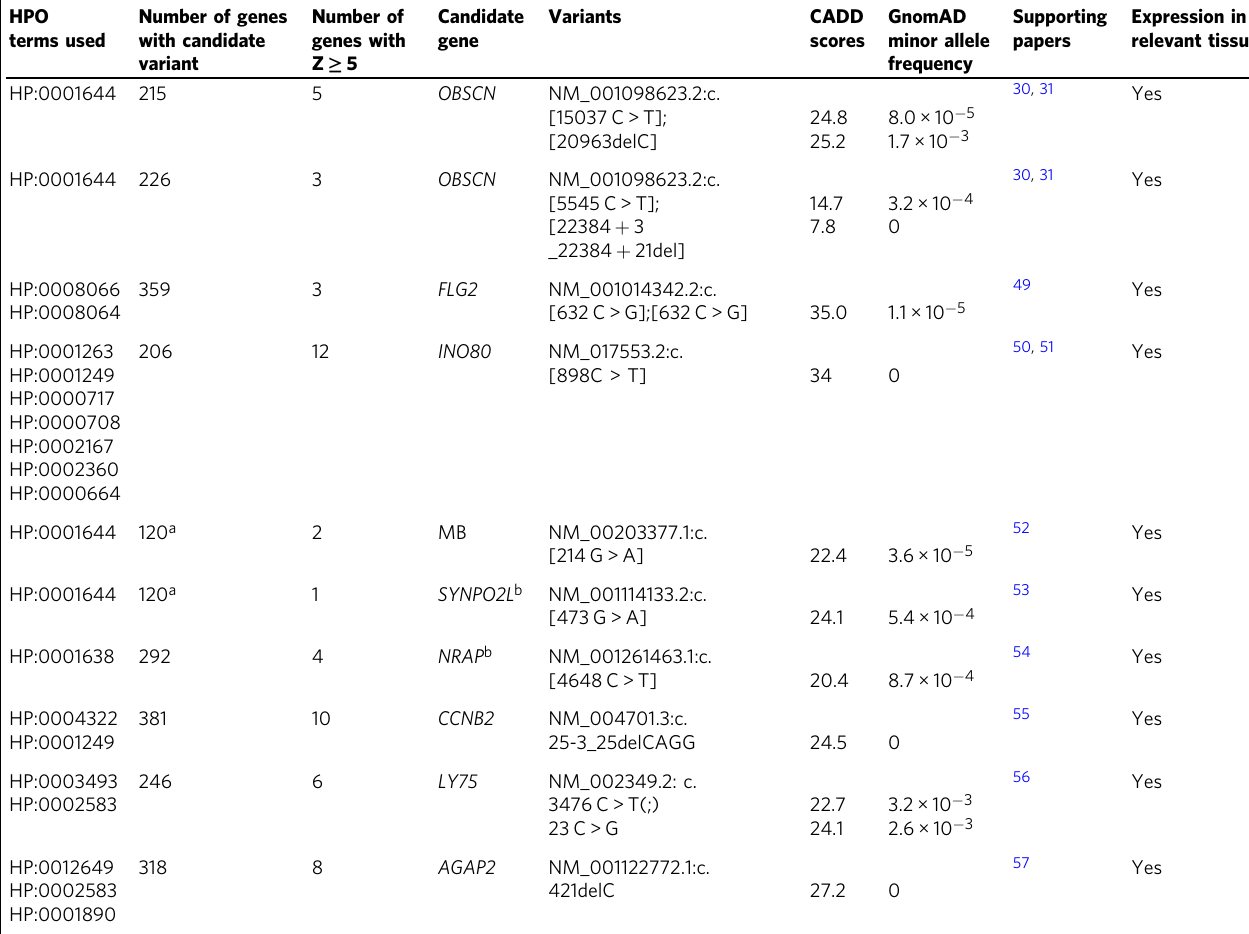
Table 2 Unsolved cases with new candidate